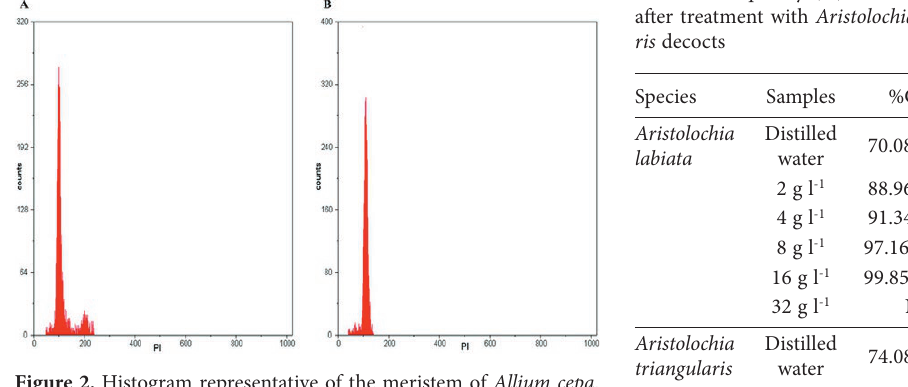
Figure 2. Histogram representative of the meristem of Allium cepa . A) Histogram representing the negative control. Note the presence of the G 0 /G 1 peak (channel 100) G 2 /M (channel 200), and between the particles at different times is S phase of the cell cycle, showing that the negative control has particles at all stage of G 0 /M. B) His- togram representing the treatment of 16 g l -1 of Aristolochia labiata , observe particles in the peak (channel 100) demonstrating that the cells are in G 0/ G 1 , but there is no peak at (channel 200), which con- firms the no progression of nuclei for the G 2 /M phase, indicating that the extracts prevent cell proliferation.